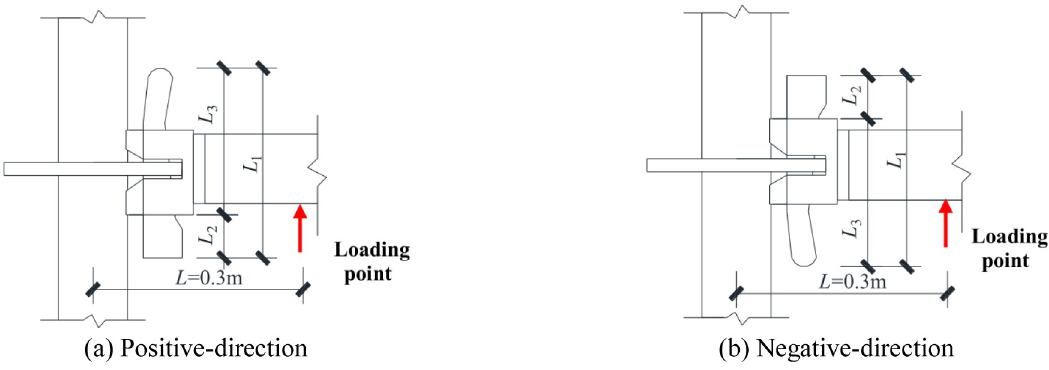
Fig 4. Dimensions schematic of the wedge insertion state. (a) Positive-direction. (b)